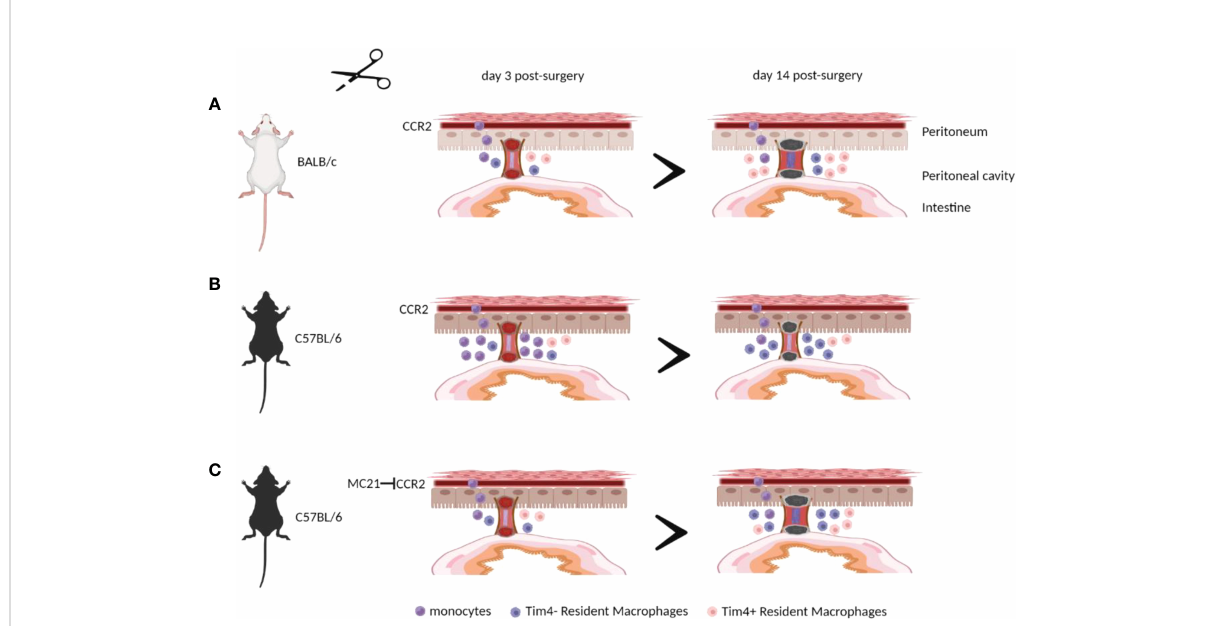
FIGURE 6 Monocytes and/or monocyte-derived peritoneal macrophages are essential in preventing peritoneal adhesion formation after surgery. BALB/c mice showed a signi fi cantly lower in fl ux of monocytes and monocyte-derived macrophages at day 3 post-surgery, leading to greater peritoneal adhesion formation at day 14 post-surgery (A) compared with C57BL/6 mice (B) . Blocking the recruitment of circulating monocytes in C57BL/6 mice resulted in an enhanced susceptibility to peritoneal adhesions after surgery (C) . The illustration was created using